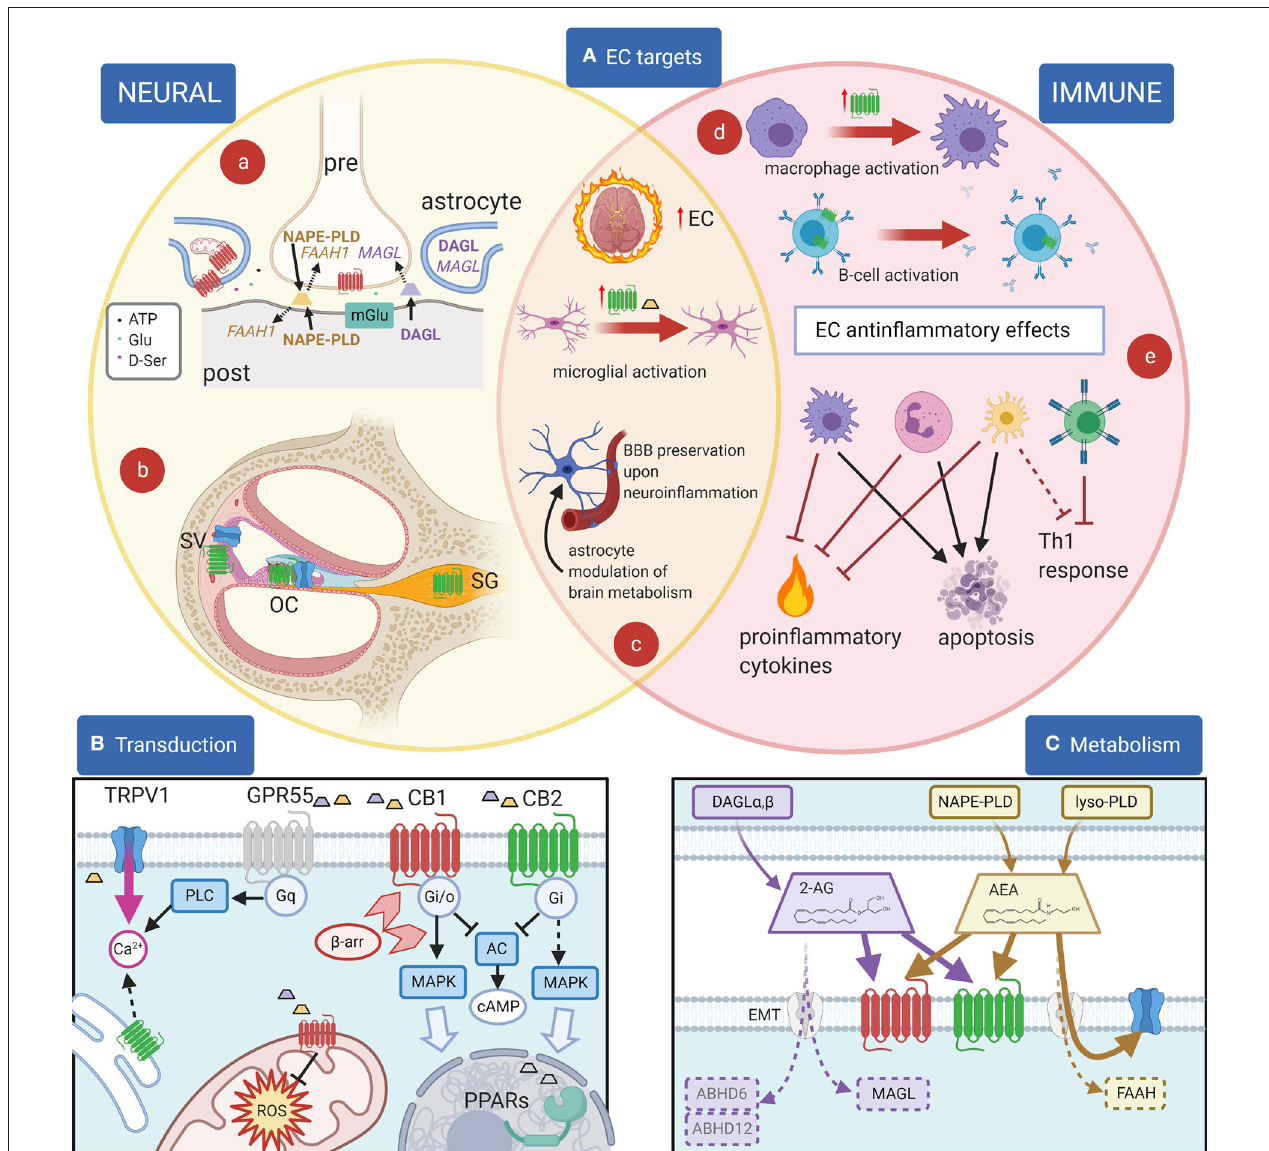
FIGURE 1 | EC and their effects. (A) : Principal EC targets in neural and immune systems, and in the cochlea. (a) In most brain areas, 2-AG (purple) is synthetized by DAGL- α in neuronal dendrites and somata and catabolized by MAGL in presynaptic terminals, where CB1R (red) are also present. 2-AG is produced postsynaptically in a Ca 2 + -dependent way upon activation of metabotropic receptors (blue) and inactivated presynaptically near its target (1). For AEA (yellow), on the other hand, the biosynthetic enzyme NAPE-PLD is both pre- and postsynaptic, and the catabolic enzyme FAAH-1 is predominantly postsynaptic (1). Astrocytes are also involved in synaptic effects through an EC modulation of gliotransmission, and in addition EC effects on astrocyte mitochondria contribute to neuronal metabolism regulation. (b) In the cochlea, CB2R (green) are found in the organ of Corti (OC), basal cells of the stria vascularis (SV) and spiral ganglion (SG), whereas TRPV1 channels (blue) are found in the organ of Corti and marginal cells of the stria vascularis. (c) During neuroinflammation, several changes are seen in the EC system. The overall EC production increases. Activated microglia increases AEA production (yellow trapezoid) and CB2R expression (green). Astrocytes become activated and BBB is affected (both effects are counteracted by EC responses). (d) Cell activation may change CB2R expression as in macrophages (purple) (2) or CB2R subcellular localization as in B lymphocytes (blue) (3). (e) Anti-inflammatory EC responses in immune cells include the block of Th1 responses due to direct effects on T cells (green) and indirect effects on dendritic cells (yellow), apoptosis induction on several cell types, and the inhibition of proinflammatory cytokines and factors. (B) : Principal EC receptors and their main intracellular pathways. Both 2-AG (purple trapezoid) and AEA (yellow trapezoid) act on CB1R and CB2R, which are class A GPCRs ( 4) coupled to Gi/o G-proteins (5, 6), reducing cAMP concentration (7). β -Arrestin binding (light red arrowheads) induces CBR internalization and switches receptor coupling, especially for CB1, also activating MAP kinase pathways (8–10) linked to nuclear effects (large light blue arrow). MAPK pathways are also activated through Gi βγ action (dotted line), both by CB1R and by CB2R (11). Functional CBRs have been also found in intracellular compartments such as the outer mitochondrial membrane (12), where they modulate cell energetic balance (13), and ROS production (14) or endoplasmic reticulum, where they may induce Gq-related Ca2 + release from intracellular stores (3). Moreover, ECs or related lipids activate nuclear PPARs (15). TRPV1 channels are often colocalized with CB1R